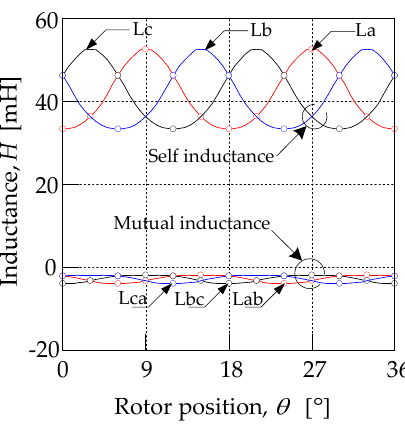
Figure 14. Winding inductances.